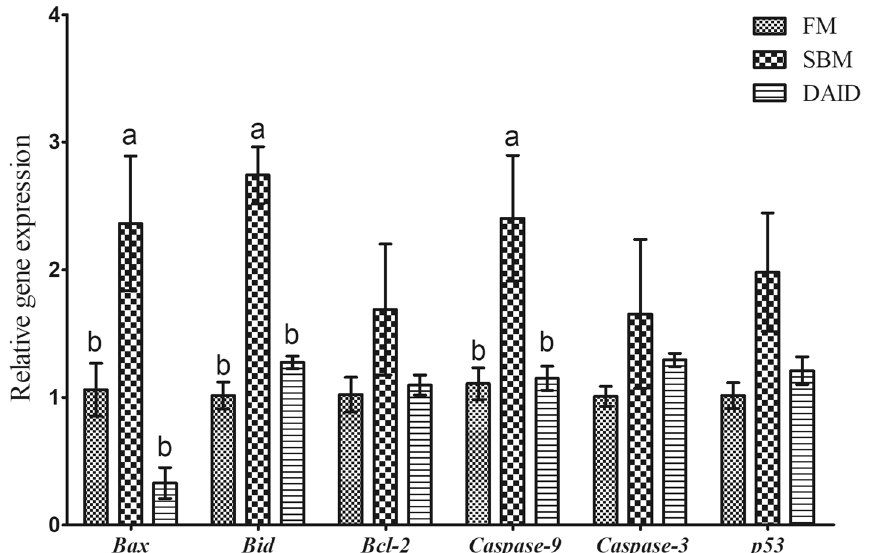
Figure 3. Effects of daidzein on gene expression of apoptotic parameters of turbot fed with soybean meal. FM fish meal diet, SBM soybean meal diet, DAID 40 mg/kg daidzein included into SBM diet. Values are mean ± SEM, n = 3 and values shared different letters are significantly different ( P <